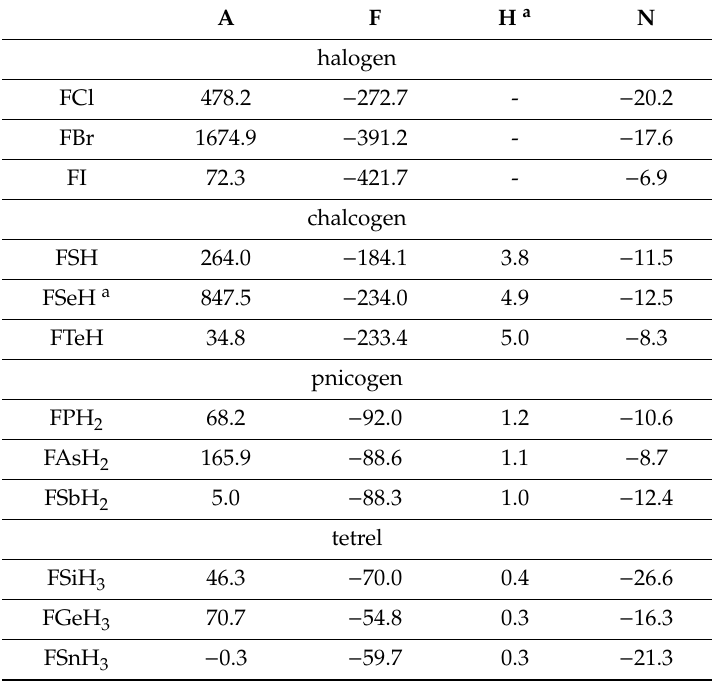
Table 2. Changes in chemical shielding (ppm) that accompany complexation with NH 3